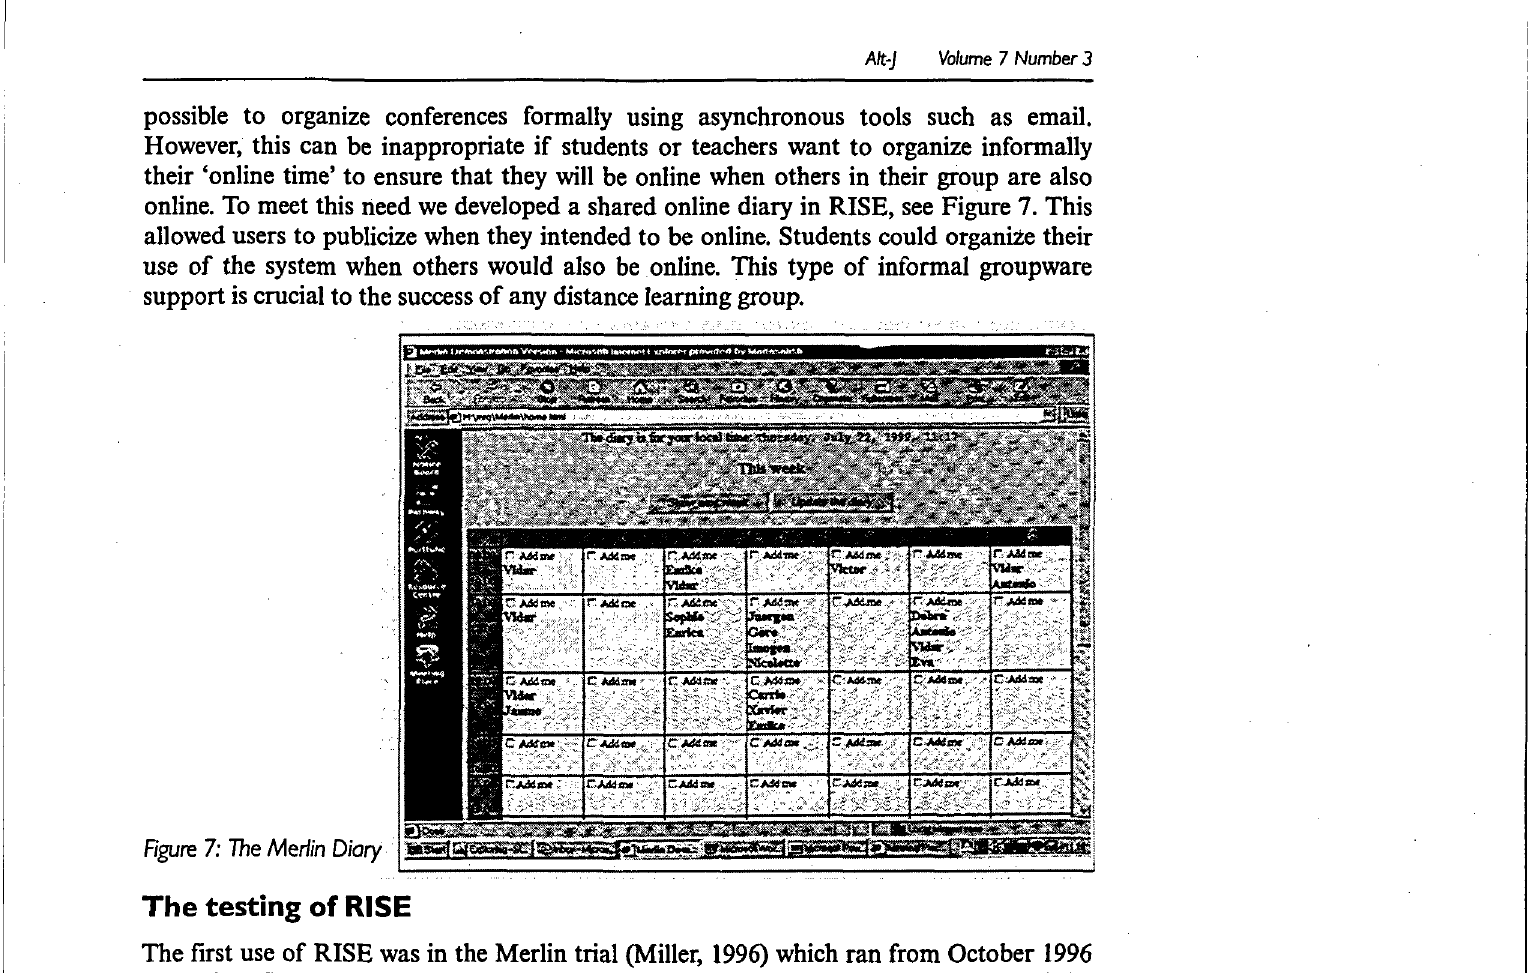
Figure 7: The Merlin